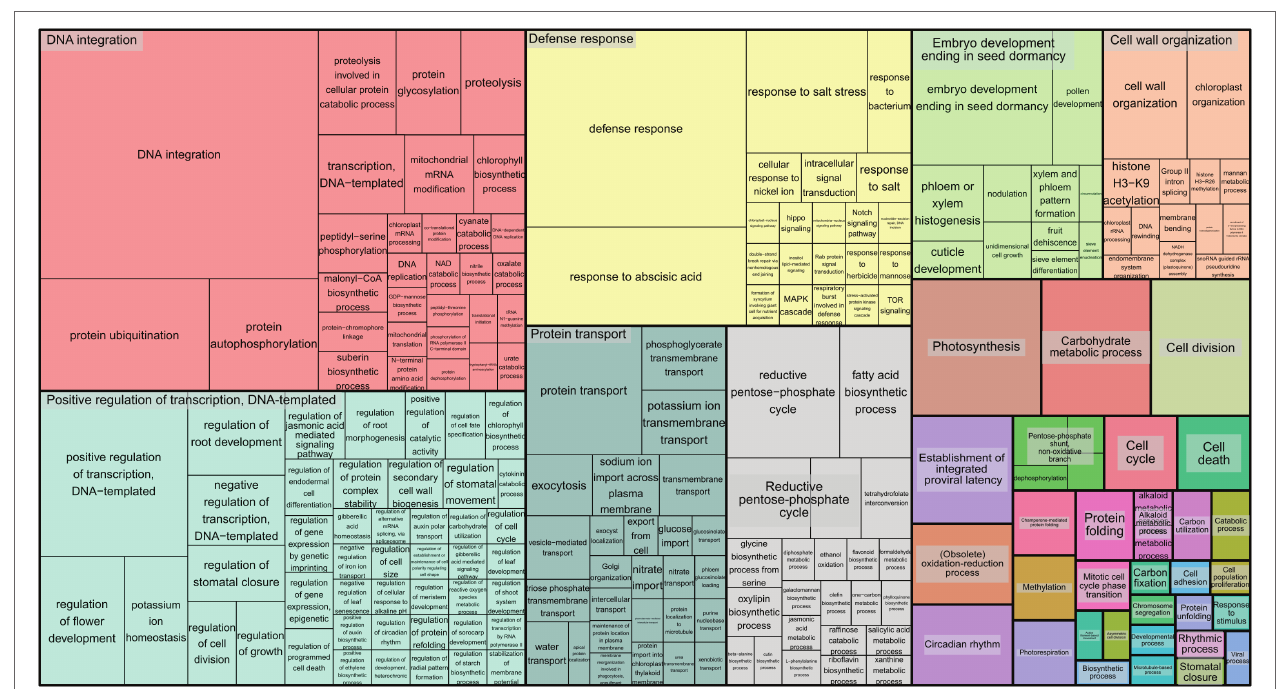
FIGURE 6 | Treemap representing the biological processes for the GO terms of the annotated functional